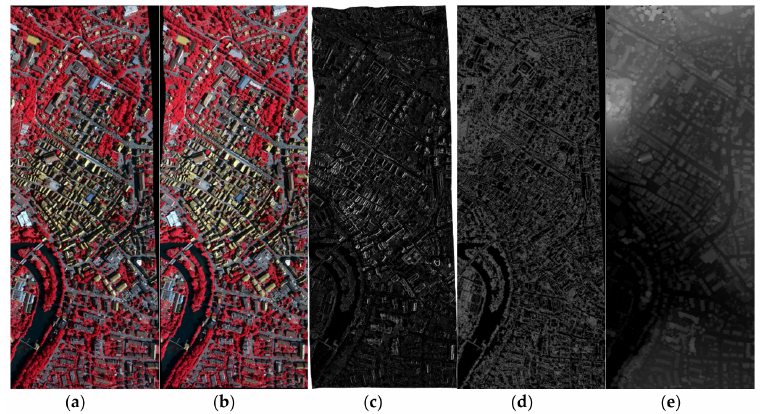
Figure 1. Different images of image pair’s overlap region. ( a ) left digital orthophoto map (DOM); ( b ) right DOM; ( c ) difference image of ( a , b ); ( d ) edge image of ( a ); ( e ) digital surface